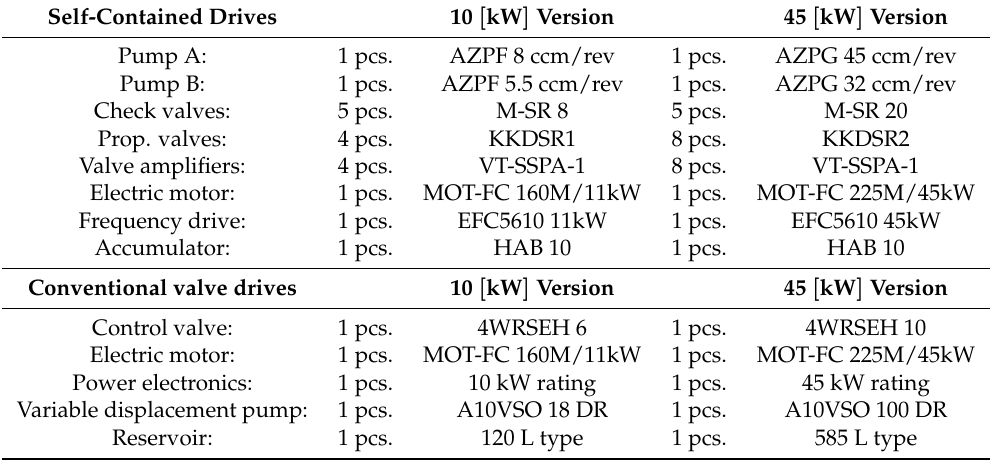
Table 4. Components used as basis for commercial feasibility study. Note that all components (except for reservoirs) are included in the Bosch Rexroth standard component program. Note that the reason for the use of 8 proportional valves and associated amplifiers in the 45 [ kW ] case is a result of the required flow and the valve sizes available.